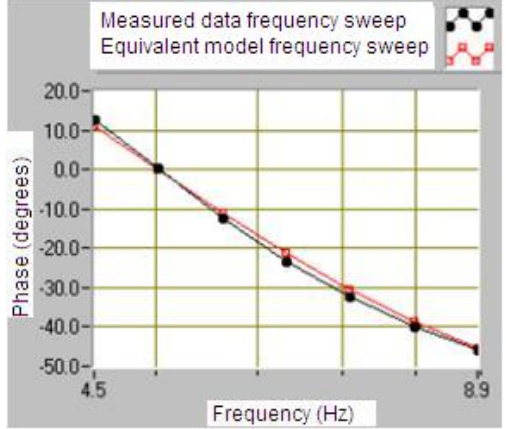
Figure 15. Comparative with data measured and calculated of the geophone SM-6 sensitivity in degrees through the